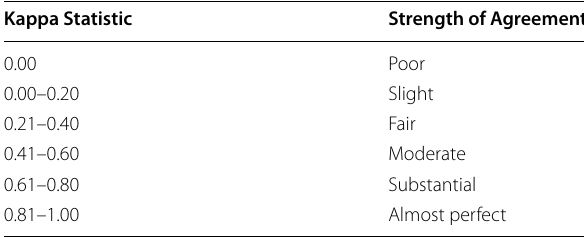
Table 4 Agreement Kappa statistic measures for